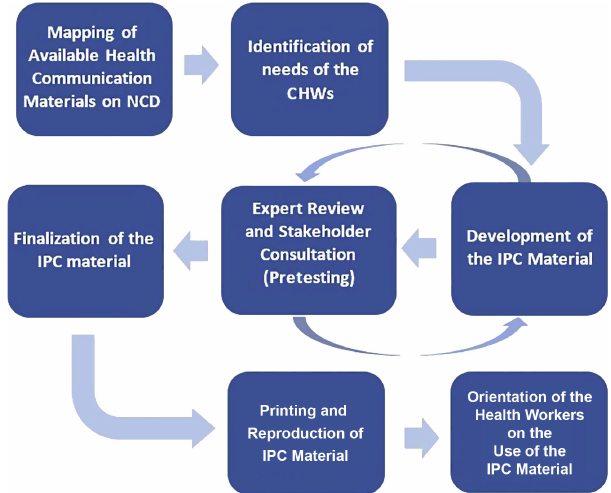
Figure 1. Systematic process